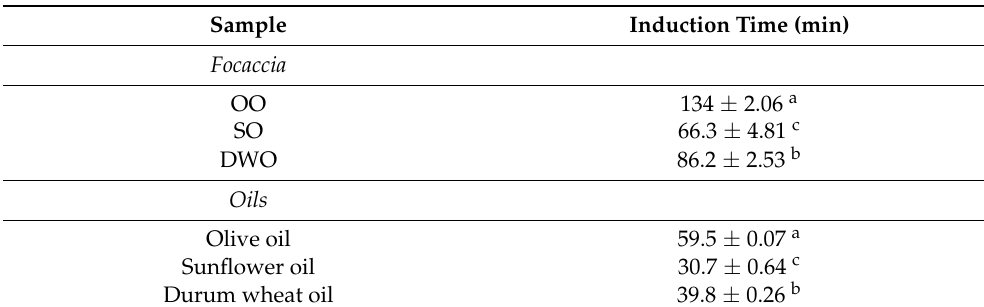
Table 2. Resistance to forced oxidation of the oils and focaccia . SO = focaccia with sunflower oil; OO = focaccia with olive oil; DWO = focaccia with durum wheat oil.